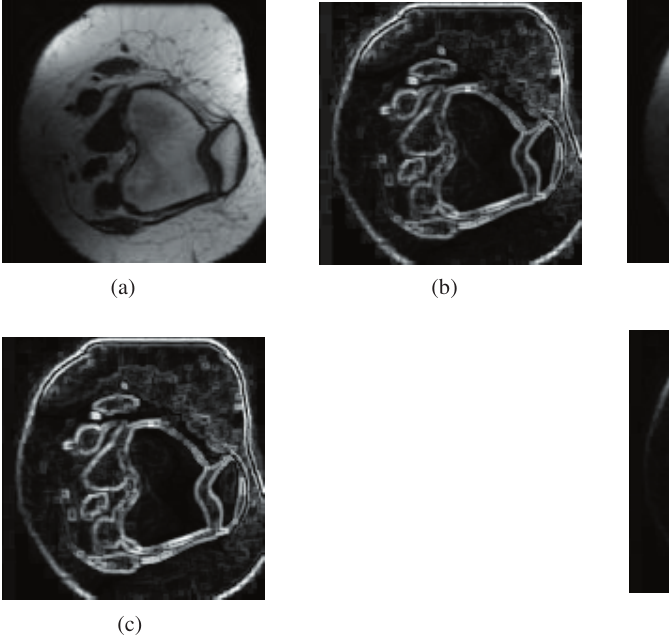
Fig. 2. : a) knee patella image, b) edge image using (cid:2) = 0.3, c) edge image using (cid:2) = 0.75